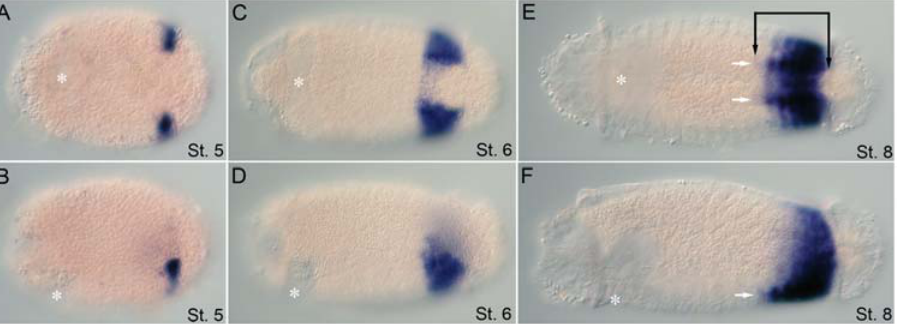
Figure 12. CapI-Post2 expression in larval stages. Anterior is to the left for all panels. Stages are marked at the bottom right of each panel. (A), (C), and (E) show ventral views; (B), (D), and (F), lateral views with ventral down. The mouth is marked by an asterisk. (A, B) Initial expression is in ventrolateral ectodermal bands that span segments A1 and A2 during stage 5. Note absence of expression across the ventral midline. (C, D) By stage 6, additional abdominal segments have formed, and these segments also express CapI-Post2 . Expression across the ventral midline appears, although it is weaker than the lateral expression domains. (E, F) At stage 8, expression is apparent in the VNC (white arrows) and in the ventral and lateral epidermis of all abdominal segments (black